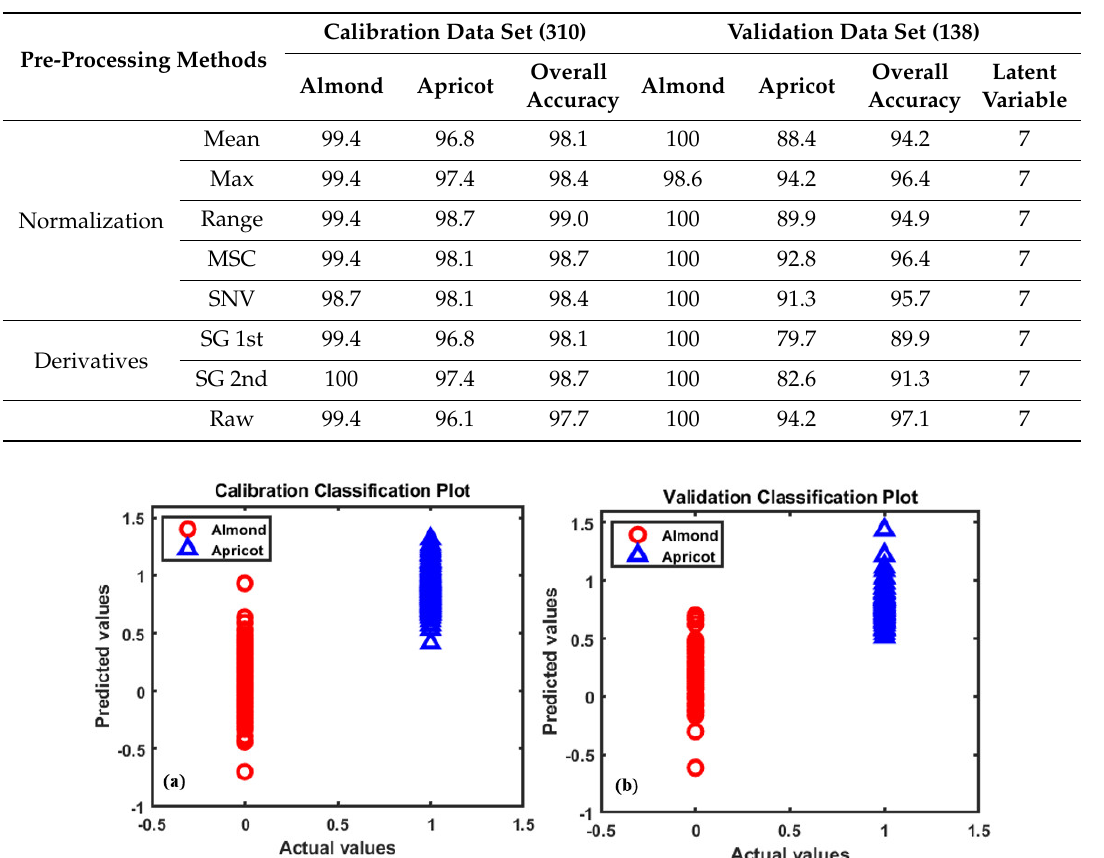
Figure 6. The partial least square discrimination analysis (PLS-DA) classification plots for almonds and apricot seeds based on the raw preprocessing.